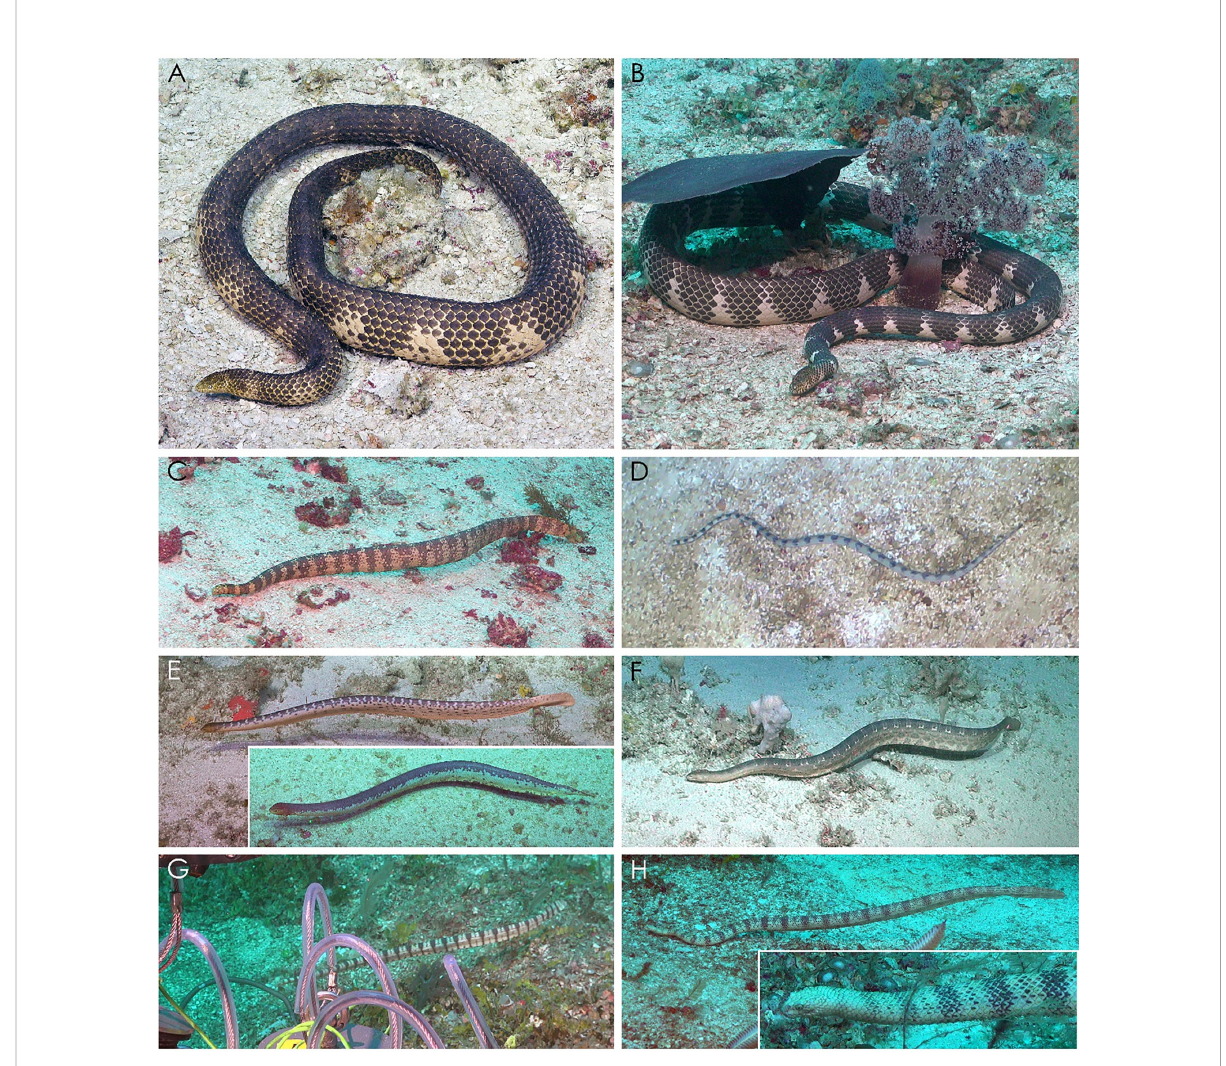
FIGURE 3 Photographs of sea snakes obtained during the ROV survey at Ashmore Reef in 2021. (A) Aipysurus apraefrontalis, (B) Aipysurus duboisii, (C) Emydocephalus orarius, (D) Hydrophis coggeri, (E) Aipysurus laevis (colour variations), (F) Hydrophis ocellatus, (G) Hydrophis kingii, and (H) Hydrophis peronii (with closeup of